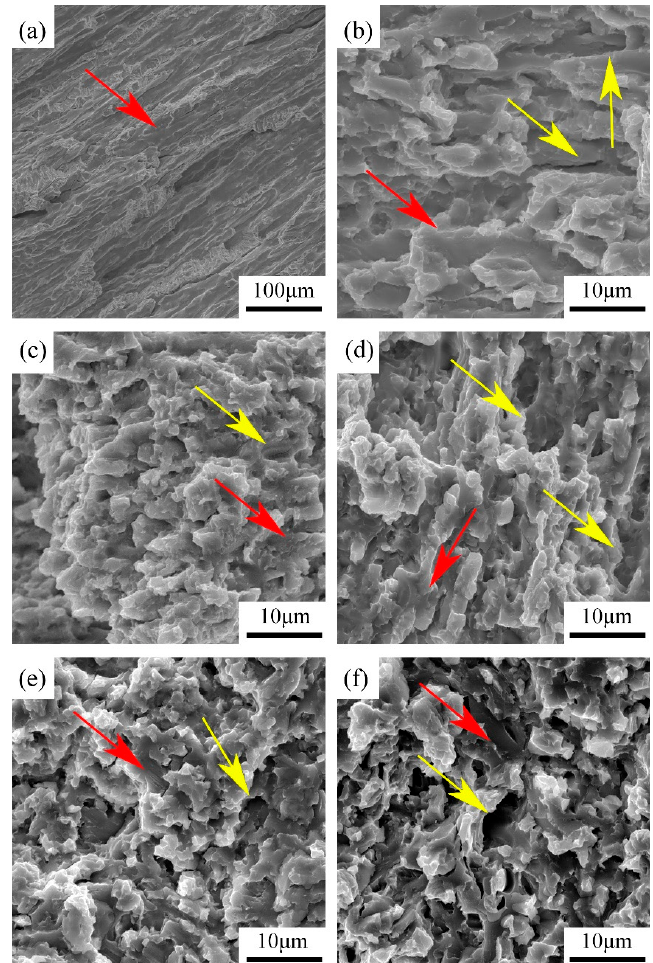
Figure 6. The fracture surface morphology of Zr 50 − x/2 Co 50 − x/2 Al x alloys after tension at ambient temperature: ( a ) Zr 50 Co 50 ; ( b ) Zr 48 Co 48 Al 4 ; ( c ) Zr 47.5 Co 47.5 Al 5 ; ( d ) Zr 47 Co 47 Al 6 ; ( e ) Zr 46.5 Co 46.5 Al 7 ; ( f ) Zr 46 Co 46 Al 8 . Holes formed by grain pull-out indicated by yellow arrows, and cleavage planes indicated by red arrows.